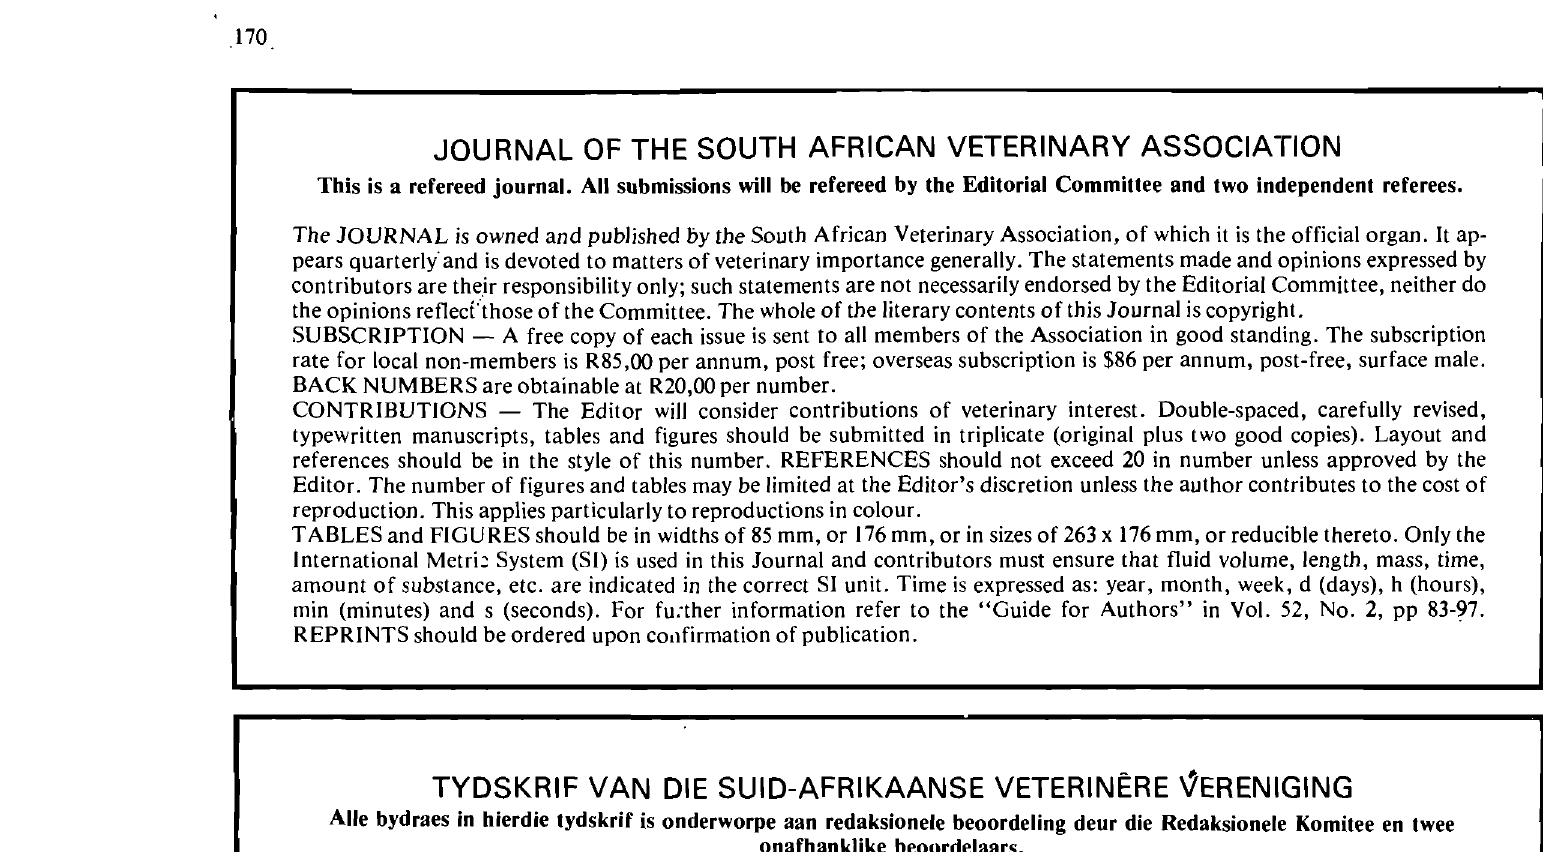
TYDSKRIF VAN DIE SUID-AFRIKAANSE VETERINERE \7ERENIGING Aile bydraes in hierdie tydskrif is onderworpe aan redaksionele beoordeling deur die Redaksionele Komitee en twee onafhanklike